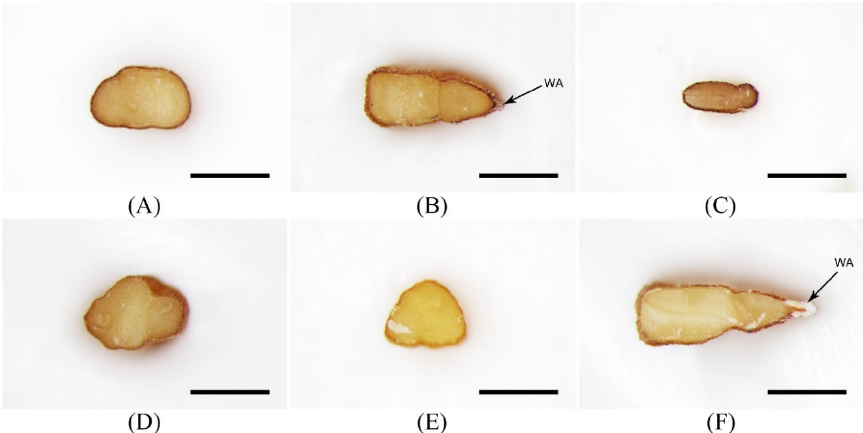
Figure 2. Stereomicroscope micrographs showing the cross-sectional shape of seeds. ( A ) Descurainia Sophia ; ( B ) Lepidium apetalum ; ( C ) Draba nemorosa ; ( D ) Erysimum cheiranthoides ; ( E ) Erysimum macilentum ; and ( F ) Lepidium virginicum . WA: Wing-like appendage. Scale bars = 0.5 mm.